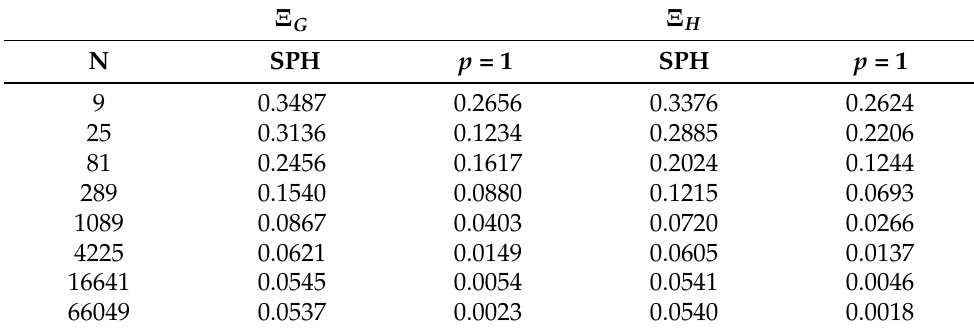
( 0 ) with p = 1. Data sites Ξ G h